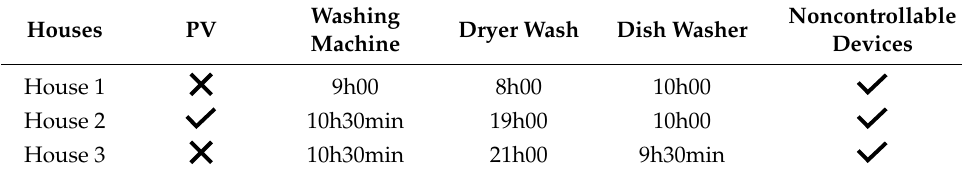
Table 3. Electrical appliance considered for this work. Table 4. Houses’ initial characteristics.